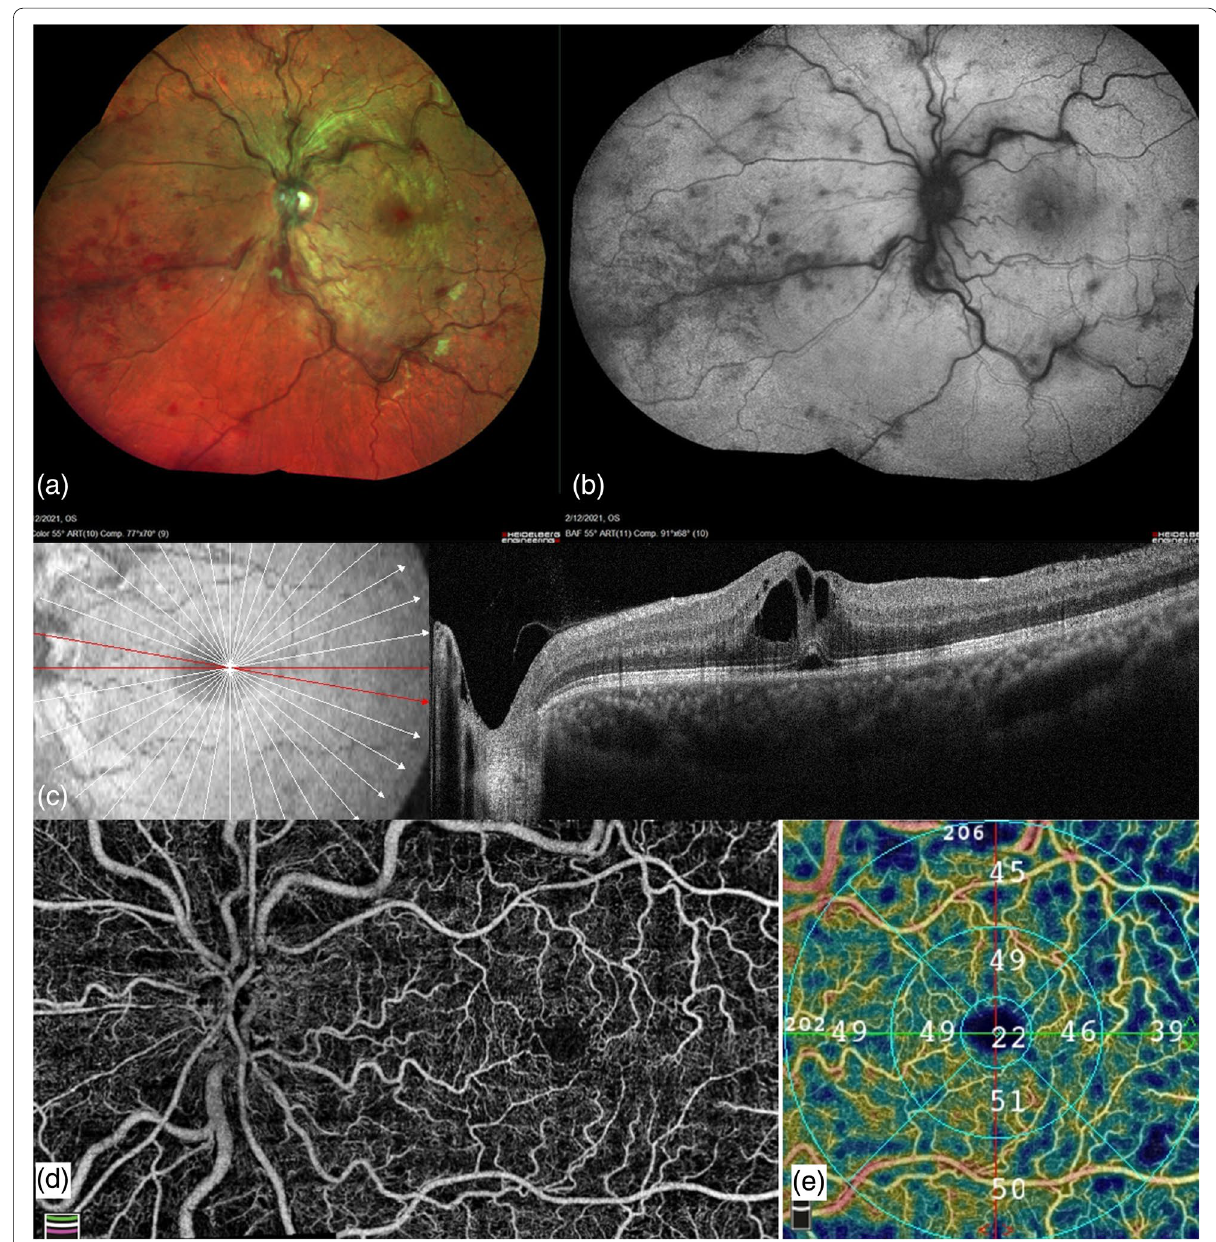
Fig. 1 Multimodal imaging of left eye central retinal vein occlusion post ChAdOx1 nCoV-19 vaccination. At the first visit (one week post vaccination). a , b Multicolor fundus imaging and corresponding short-wave fundus autofluorescence showing disc hyperemia, macular edema, multiple retinal hemorrhages and dilated tortuous veins. c Structural spectral domain optical coherence tomography (SD-OCT) showing cystoid macular edema and neurosensory detachment. d Montage optical coherence tomography angiography (OCTA) image of the optic disc and macula showing flow void areas. e Reduction of vessel density in superficial capillary plexus on